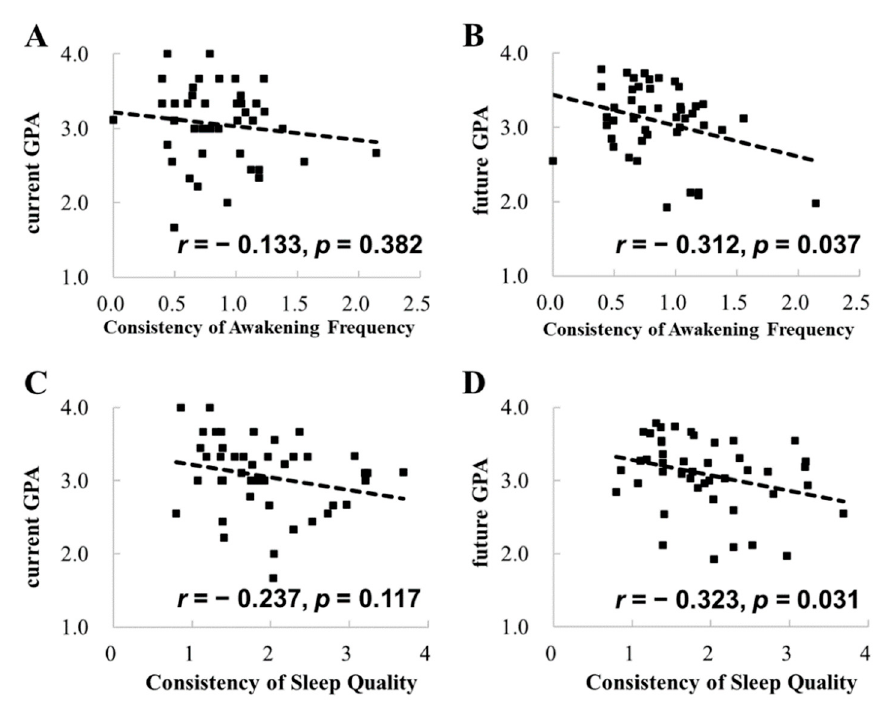
Figure 3. Figure 3. Correlations between the consistency of awakening frequency and the current and future GPAs ( A , B ), and correlations between the consistency of self-reported sleep quality and the current and future GPAs ( C , D